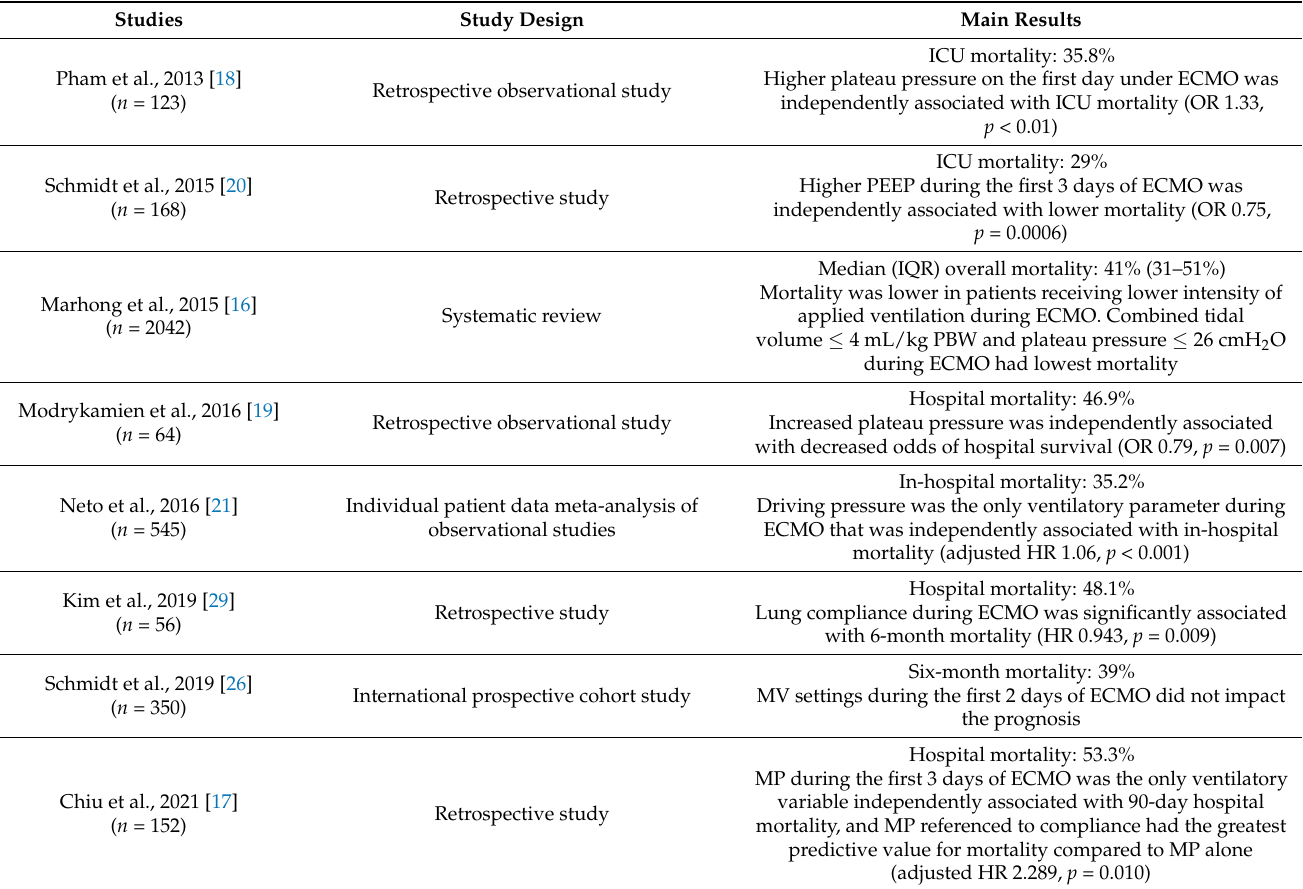
ECMO: extracorporeal membrane oxygenation; ARDS: acute respiratory distress syndrome; ICU: intensive care unit; OR: odds ratio; PEEP: positive end-expiratory pressure; IQR: interquartile range; PBW: predicted body weight; HR: hazard ratio; MV: mechanical ventilation; MP: mechanical